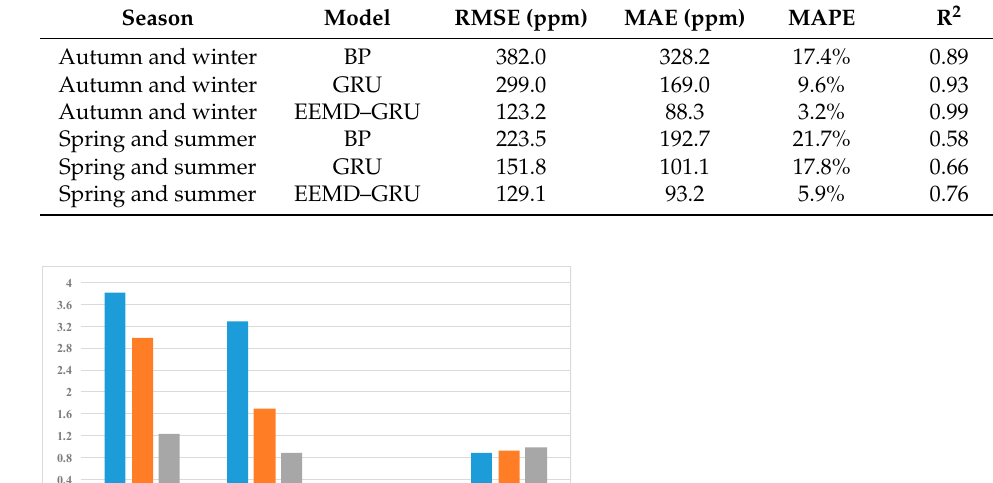
13 of 16 Figure 9. Scatter plot of EEMD–GRU model. Note: The data on the left are autumn and winter, the data on the right are spring and summer. 3.2. Discussion It can be seen from the above analysis that the prediction effect of the EEMD–GRU model is the best. In order to accurately measure the improvement effect of the model